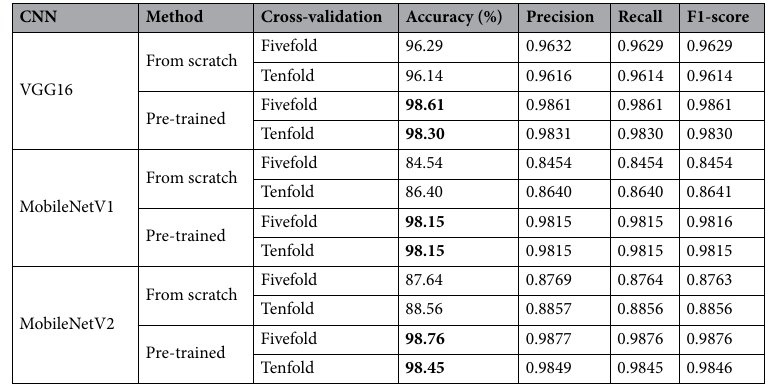
Table 1. Performance comparisons of VGG16, MobileNetV1 and MobileNetV2, comparing models trained from scratch with pre-trained models as well as fivefold versus tenfold cross-validation.0 . Values in bold represent the highest accuracy scores obtained for each of the three models.